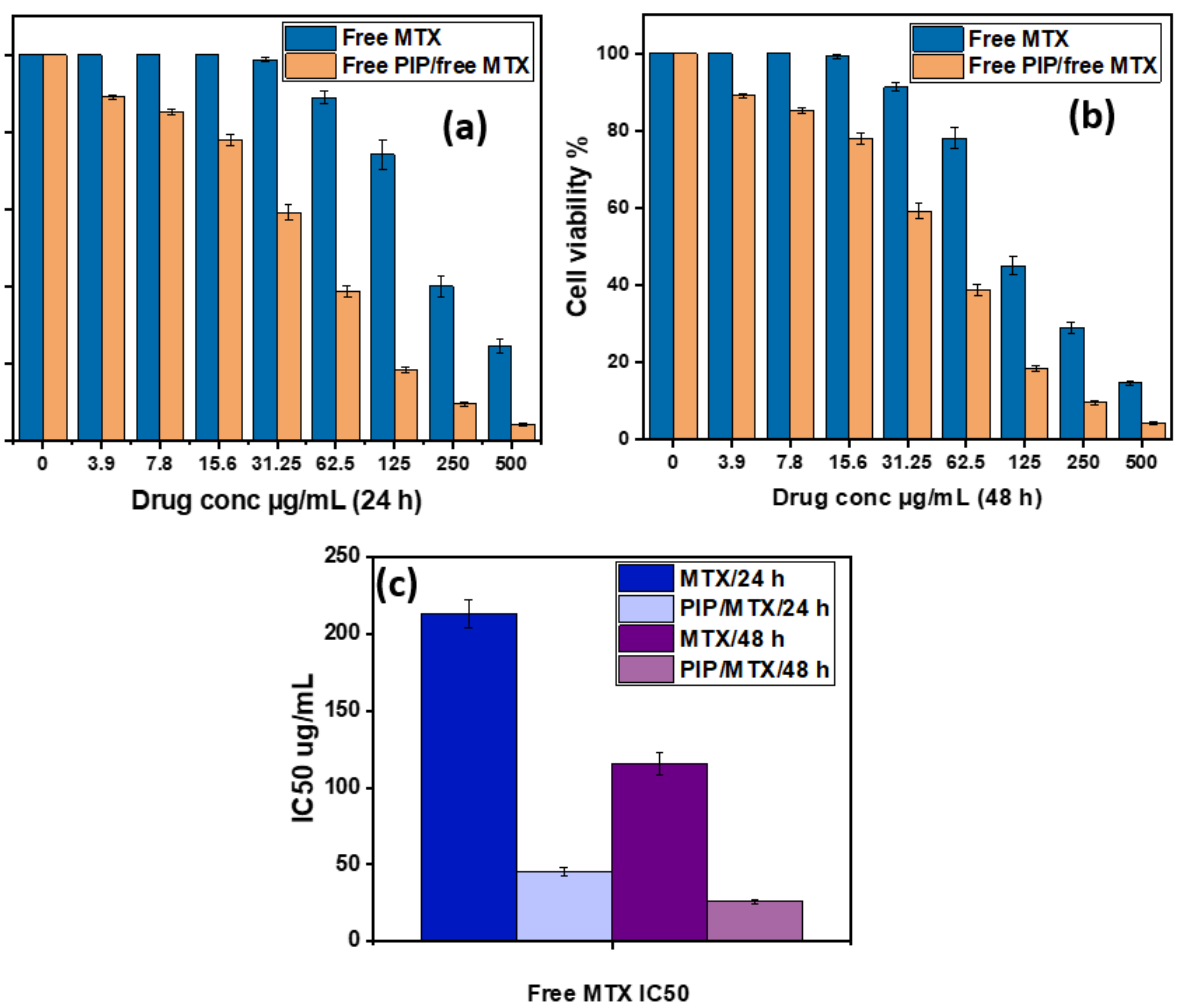
Figure 4. The cytotoxicity test on MCF-7 cells of free MTX individually, and the mixture of free drugs (PIP/MTX) using half IC 50 of the bioenhancer, free PIP at ( a ) 24 and ( b ) 48 h, and ( c ) the IC 50 values from the cytotoxicity assay of free MTX only and of the mixture of free drugs (PIP/MTX) at 24 and 48 h, respectively.